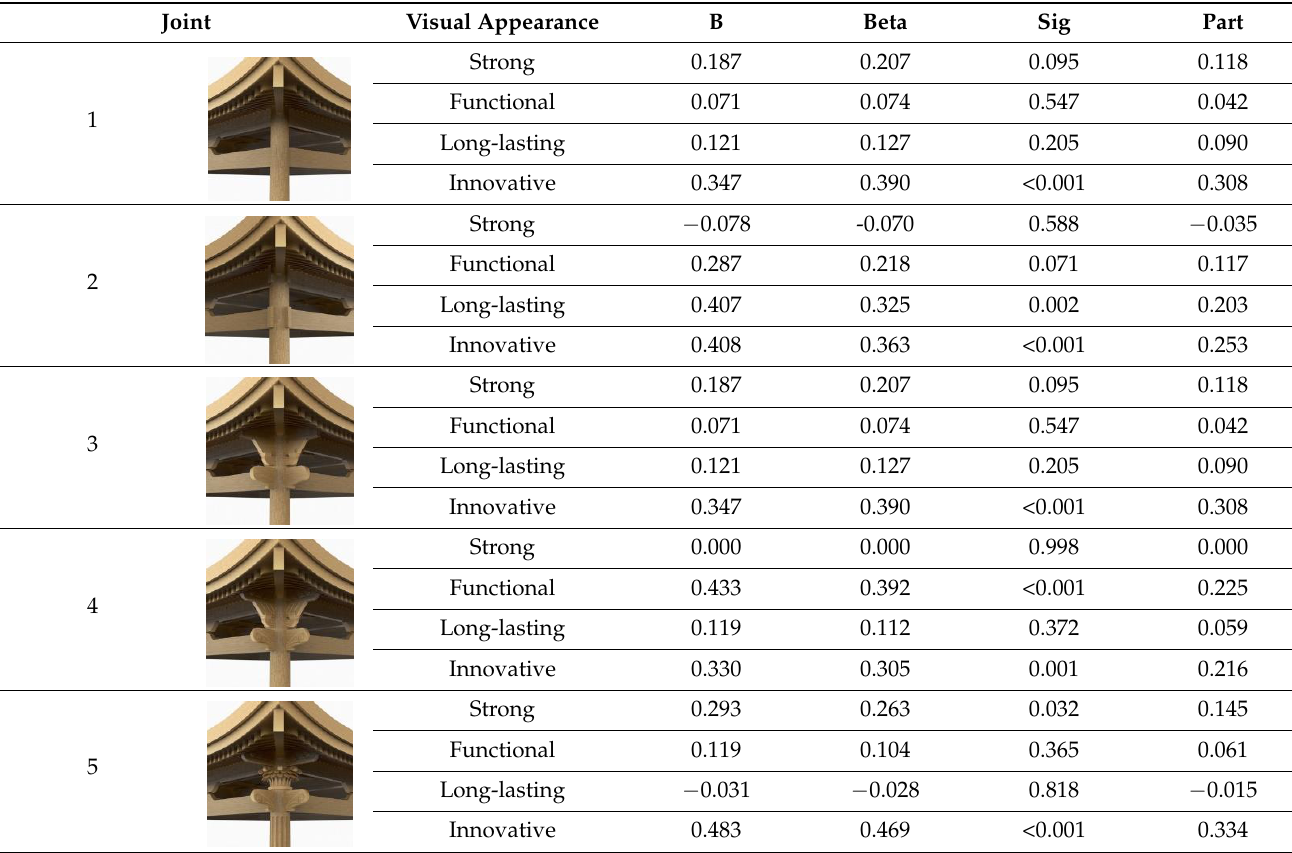
Table 3. Coefficients ( a ) of aesthetic preference of timber joints.